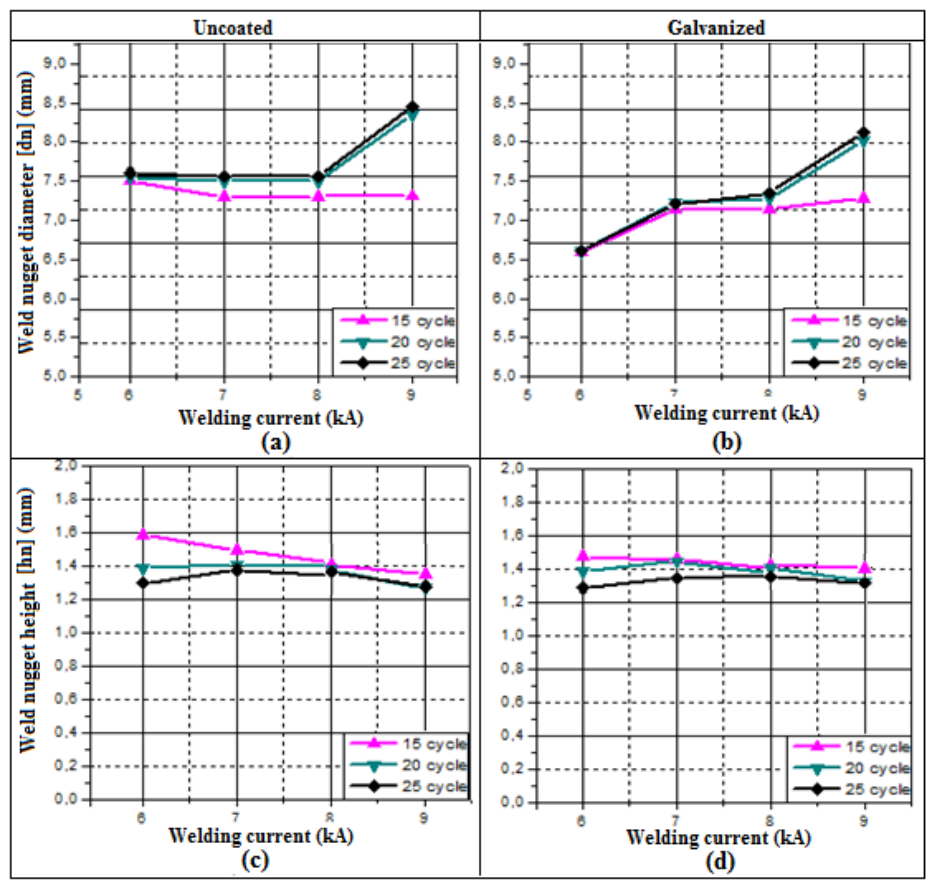
Figure 4. Effect of welding parameters on the weld nugget diameter and the nugget height of welded samples: ( a , c ) uncoated; ( b , d ) galvanized.